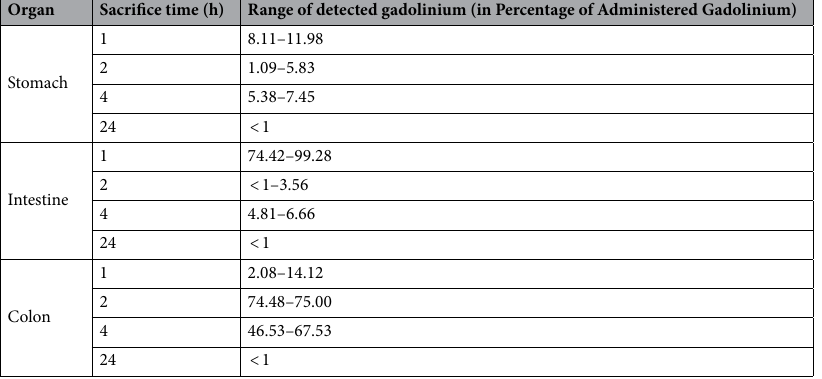
Table 1. Trend of gadolinium-marked Chitosan@DOTAGA over 24 h after oral administration in mice. The administered amount of gadolinium was 8.75 µg by the oral administration of Chitosan@DOTAGA marked with gadolinium. 2 mice per time point. All other organs assess (liver, brain, kidneys, heart, lungs, spleen, muscle, bone (skull), and skin) reported < 1% of the administered dose at all of the time points, except for one liver which reported 6% after 1